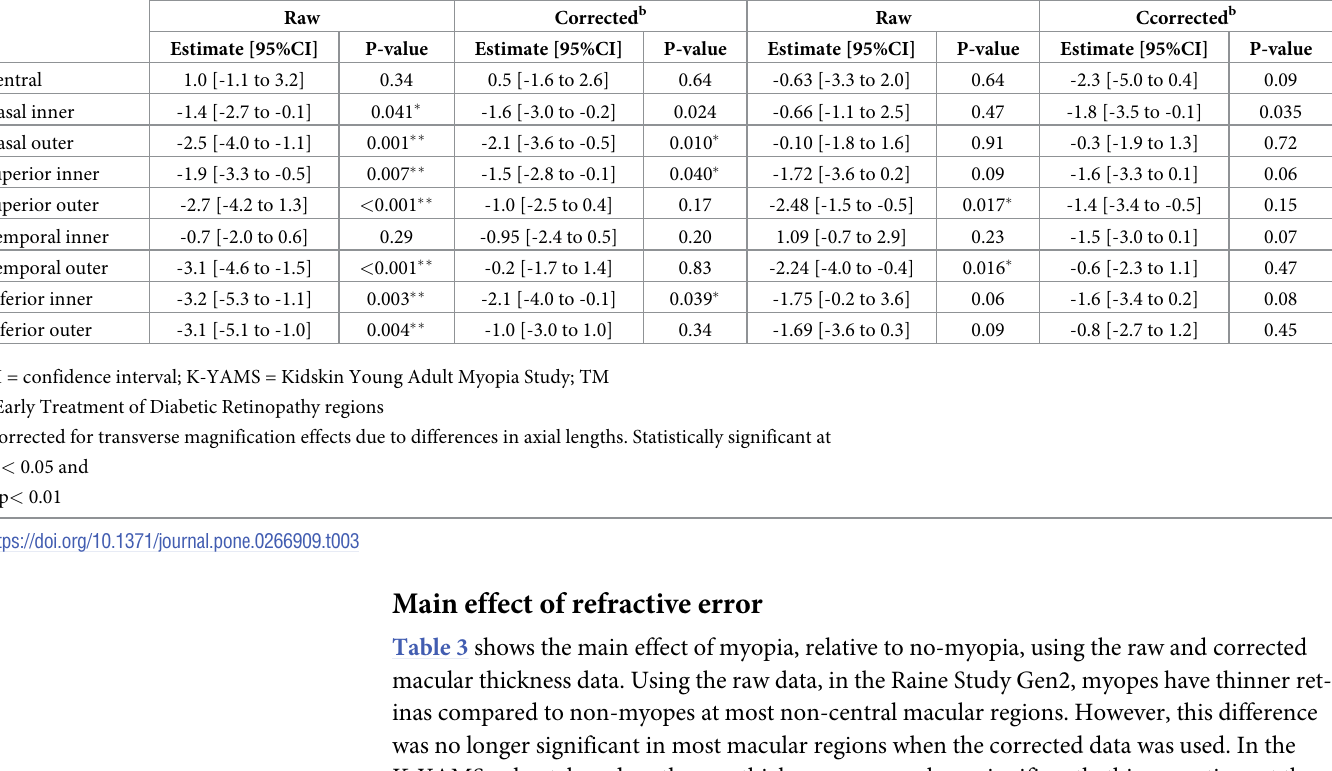
Table 3. The mean magnitude of the difference (in μ m) and 95% confidence intervals (CI) in retinal thickness of myopes (spherical equivalent � -0.50D), in com- parison to non-myopes, based on the raw and corrected data from the Raine Study Gen2 and K-YAMS cohorts. Macular region